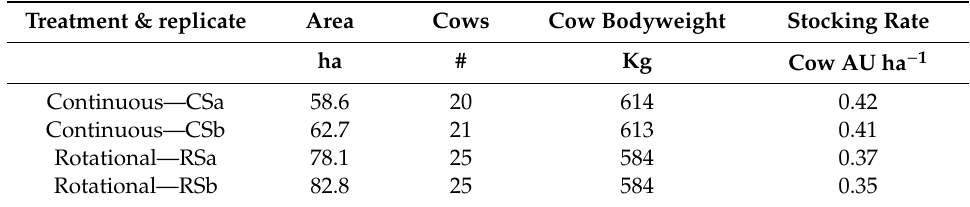
Table 2. Paddock size, cow numbers, average cow bodyweight, cow animal unit (AU), and stocking rate (500 kg per AU) for